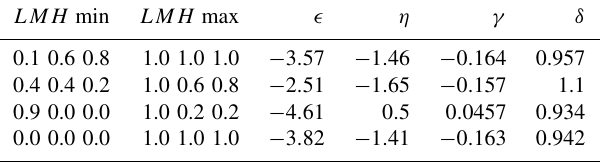
Table 1. The parameters needed for fitting M 2 and a function of M 1 and AC for each cloud regime.